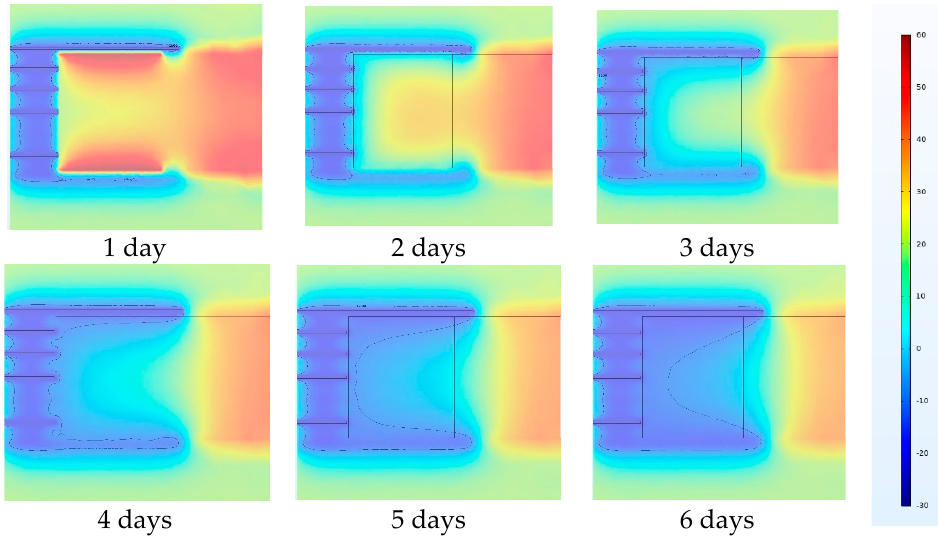
Figure 17. Temperature cloud map and isotherm of − 12 °C on Section 1.